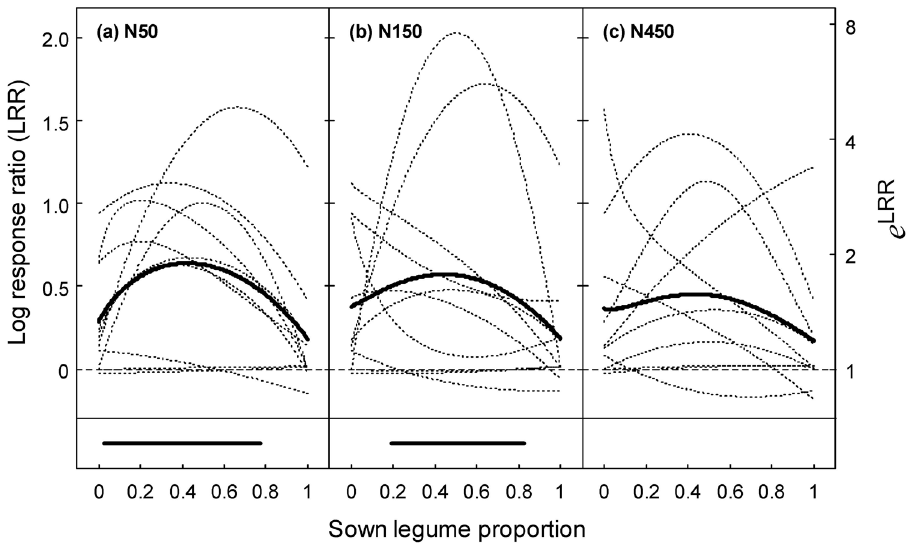
Figure 3. Multifunctionality in mixtures compared to monocultures expressed as the mean log response ratio (MLRR) (bold continuous line) across ten functions (thin dotted lines) at three N fertilisation treatments ( a ) N50: 50 kg N ha −1 yr −1 , ( b ) N150: 150 kg N ha −1 yr −1 , and ( c ) N450: 450 kg N ha −1 yr −1 . Data were averaged across years. The LRR of mixtures versus averaged monocultures was calculated for each function with values based on multivariate regression analysis (Table 2) for legume proportions between zero and one, with equal proportions of the two grass and the two legume species. It follows that the LRR at a legume proportion of 0.5 is displayed for the four-species equi-proportional mixture and the LRR at the left and right endpoints of lines is for binary mixtures. The horizontal bold line at the bottom of the panels indicates the range of legume proportion for which the MLRR was significantly different from zero ( P ≤ 0.05, based on range test 38 ).